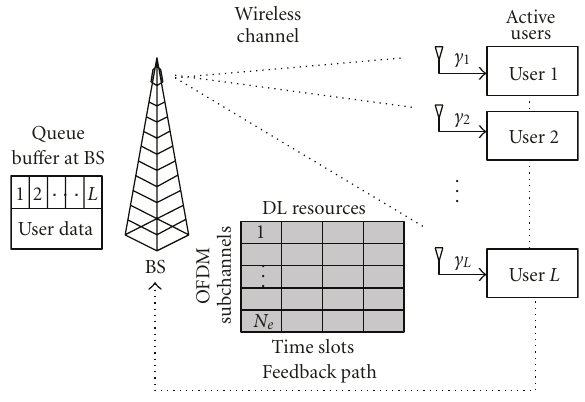
Figure 1: Downlink scheduling in WiMAX OFDMA